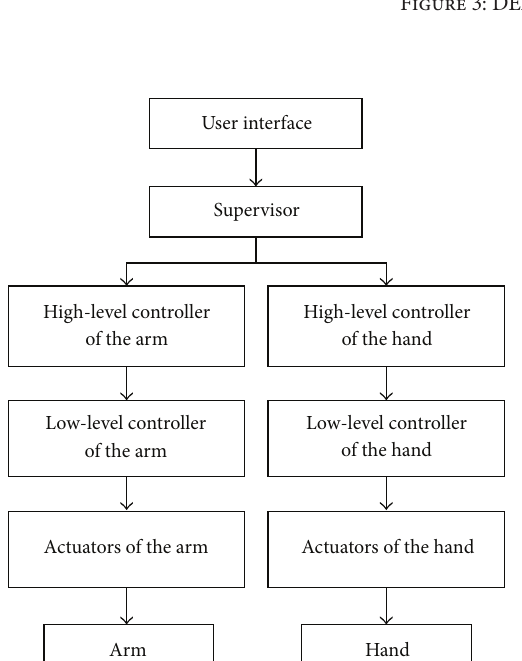
Figure 3: DEXTER DOF configuration.